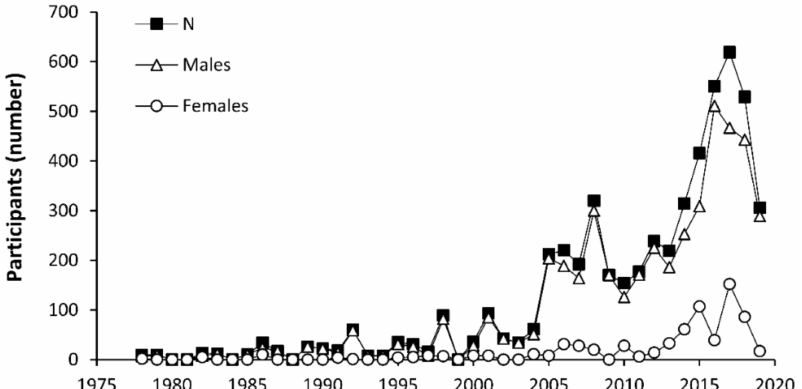
Figure 2. Evolution of the number of participants ( n = total, males and females) in investigations aimed at determining the ergogenic e ff ects of ca ff eine. Table 1. Number (frequency) of male and female participants in investigations aimed at determining the ergogenic e ff ects of ca ff eine depending on dose, type of exercise, and participant’s level.